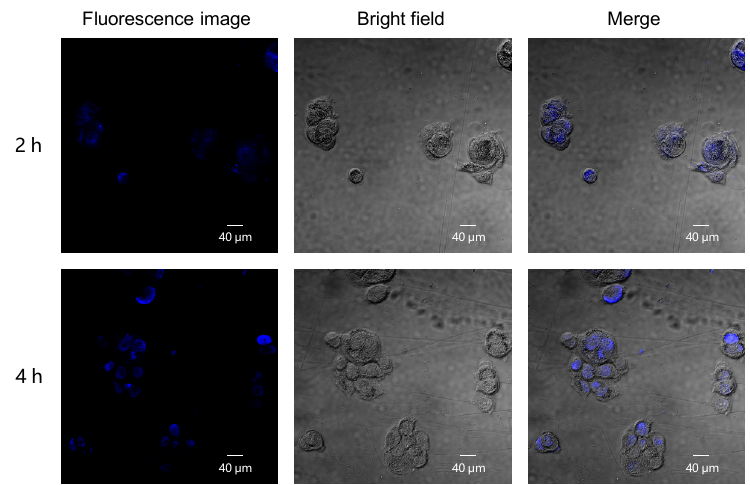
Figure 4. Cellular internalization of Bi(mPEG-S-S)-TPE micelles by MCF-7 cells.